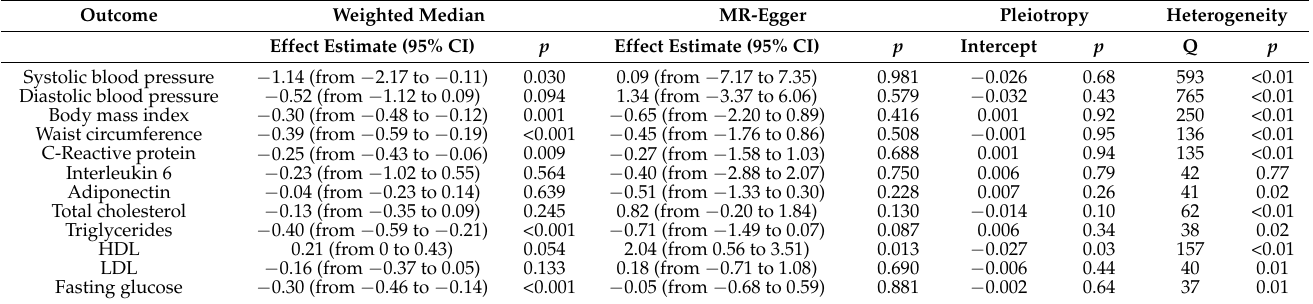
Table 2. Associations between genetically predicted cheese intake and cardiovascular biomarkers in sensitivity analyses using the weighted-median and MR-Egger